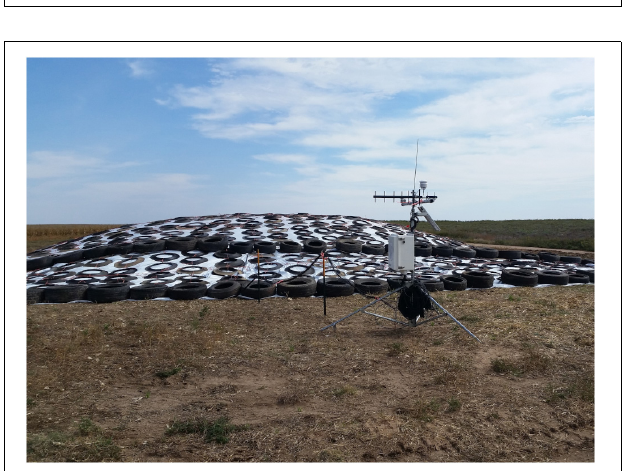
FIGURE 9 | Covered drive over storage